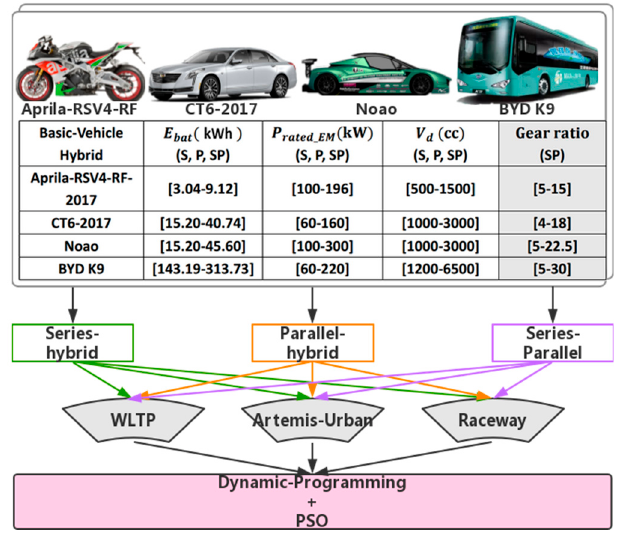
Figure 14. PSO optimization plan flow chart.